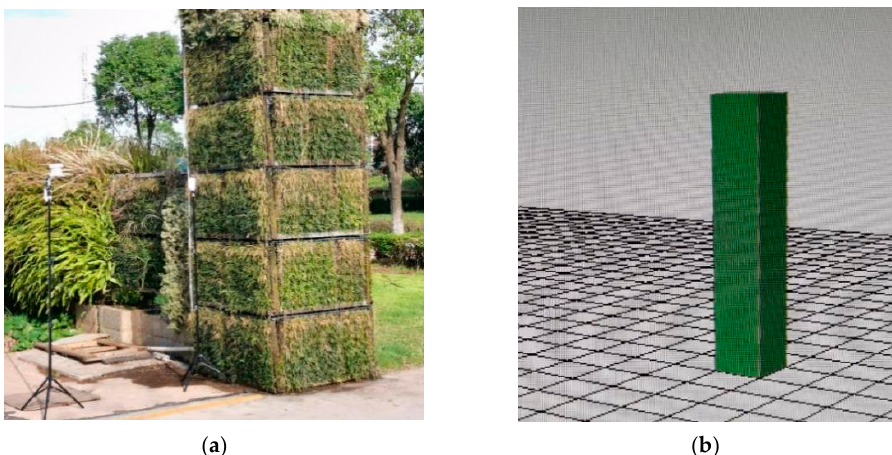
Figure 2. Validation experiment. ( a ) Field measurements; ( b ) ENVI ‐ met model of field measure ‐ ment.